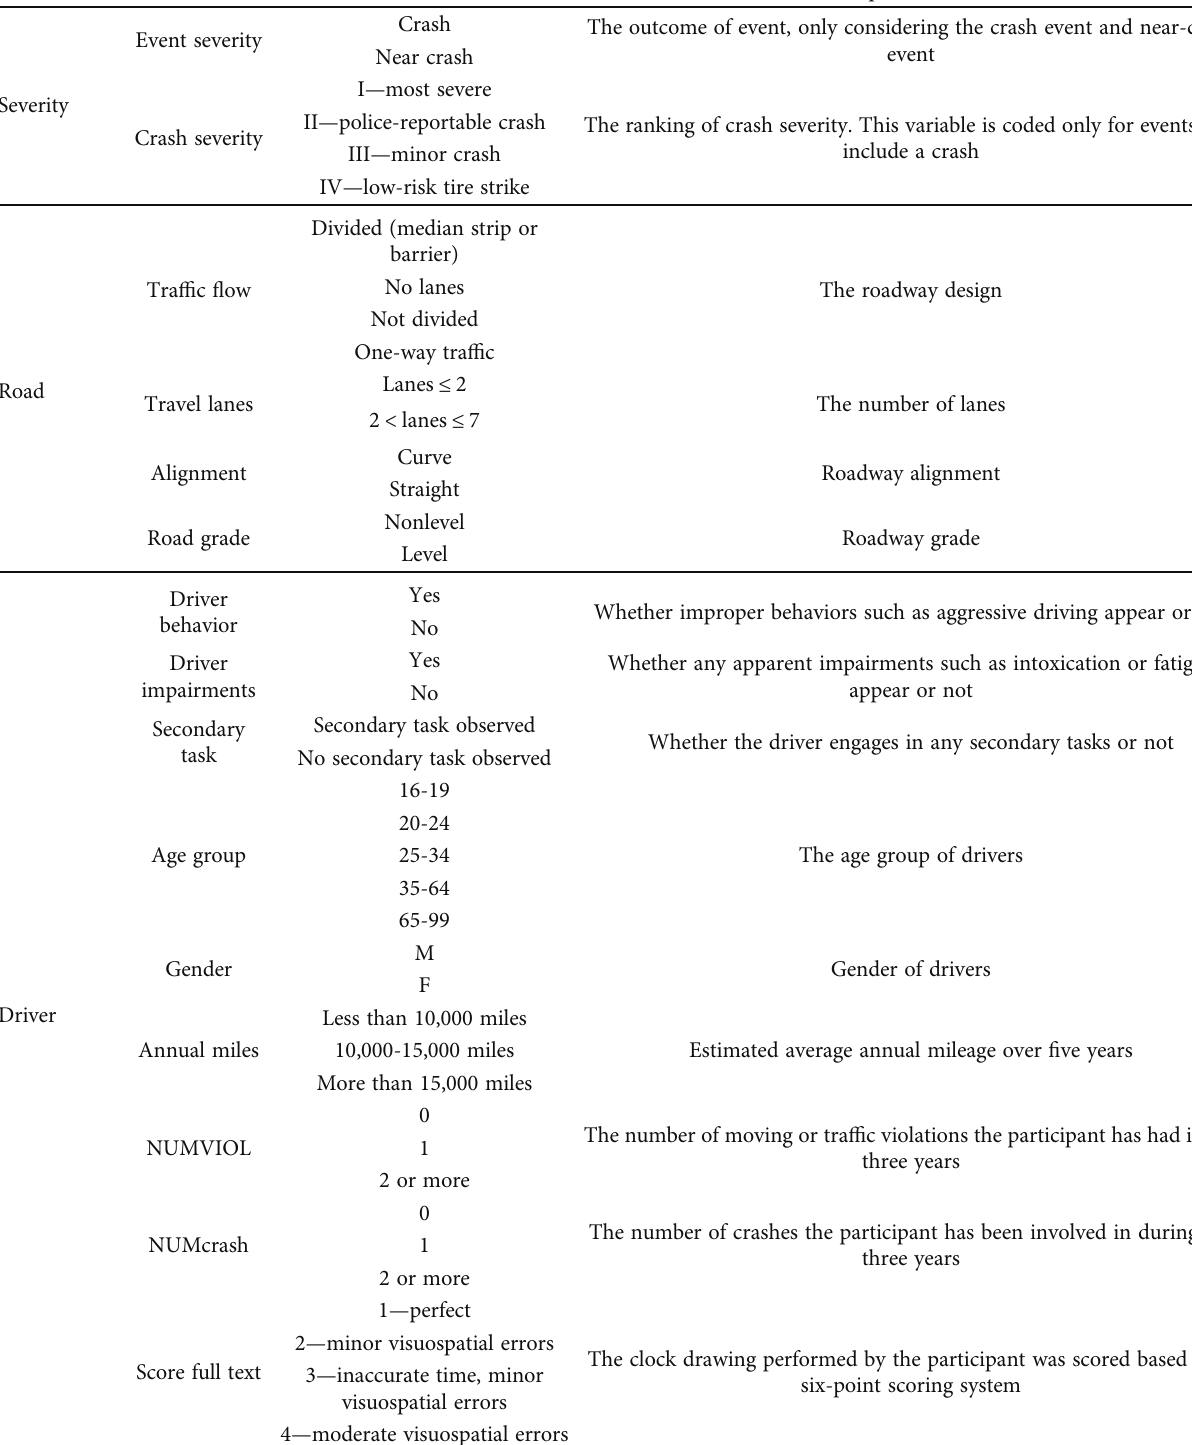
Table 2: Description of the categorical variables and their